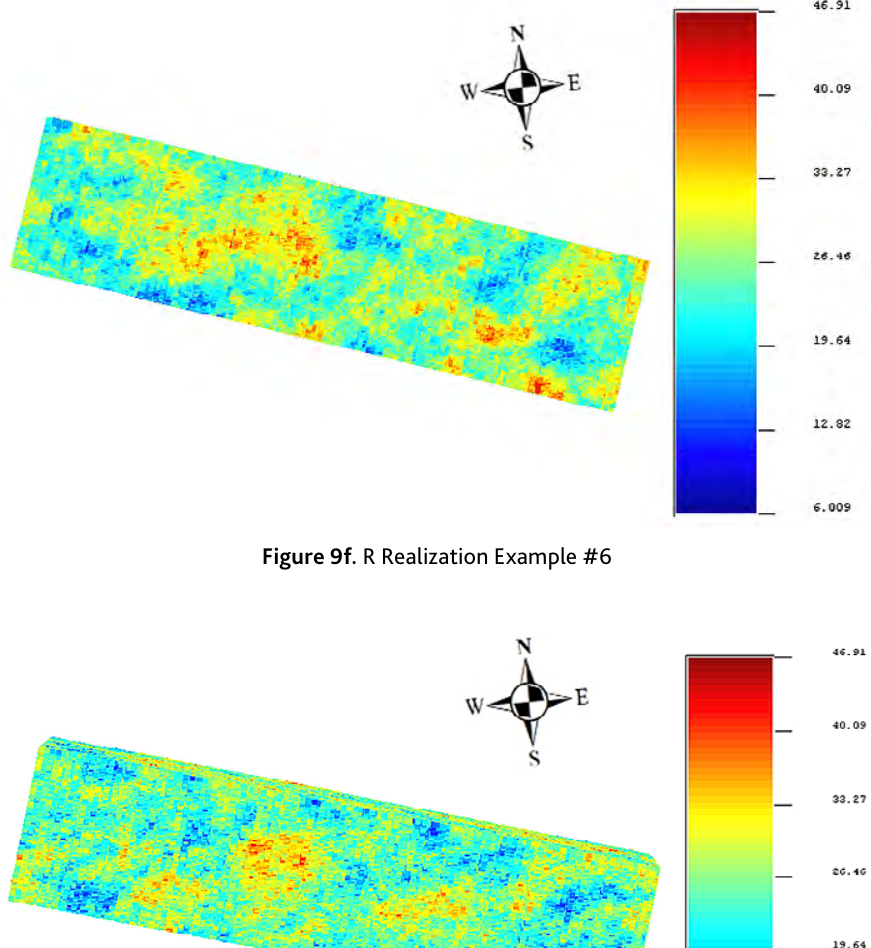
Figure 10a. R P50